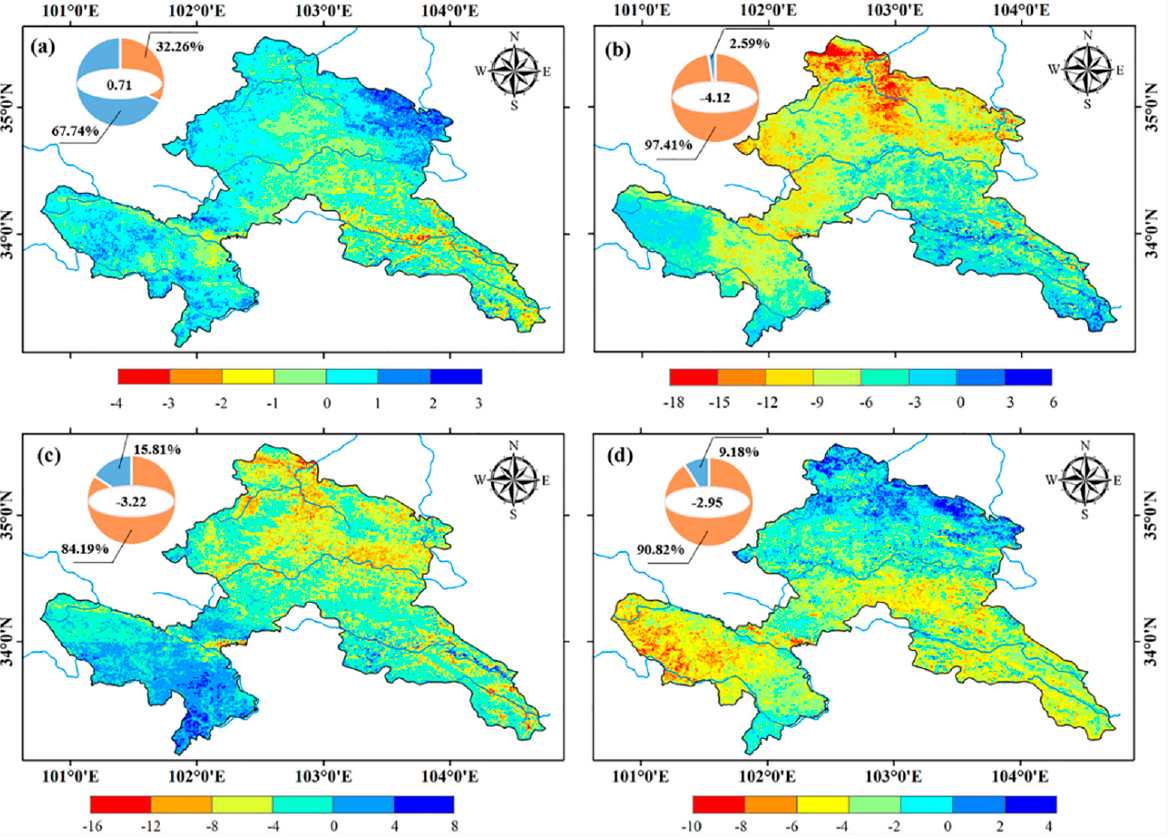
Figure 12. Spatial distribution of the SD sensitivity to the four climatic factors. Subplots ( a – d ) correspond to P, SSR, T max and T min , respectively. Fan diagrams in the upper left corners of subplots indicate the areal proportion of positively or negatively influenced and are differentiated using blue and orange, while the regional averages are the white part in the middle.